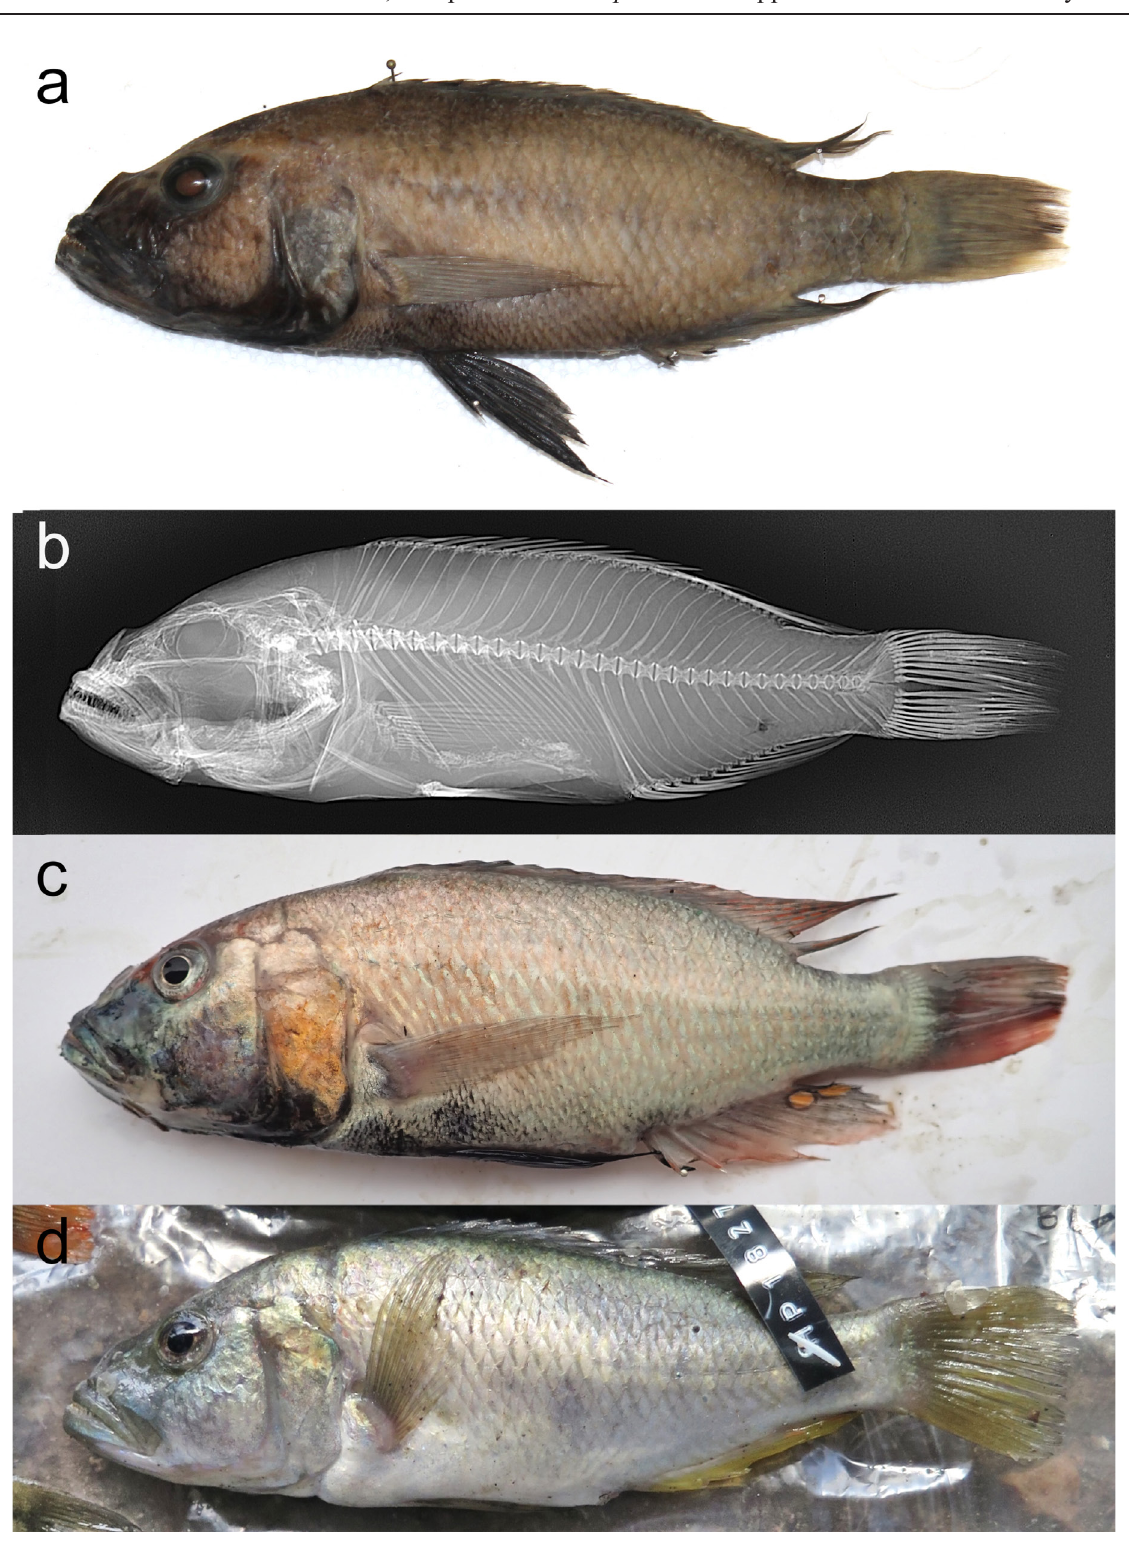
Fig. 12. Haplochromis rex sp. nov. a . Photograph of preserved holotype (RMCA 2018.008.P.0345; 148.5 mm SL). b . X-ray image of holotype c – d . Photographs of freshly caught specimens. c . Holotype, a dominant male. d . A female (RMCA 2017.006.P.0355; 135.7 mm SL) to illustrate the live colour patterns. The contrast was slightly